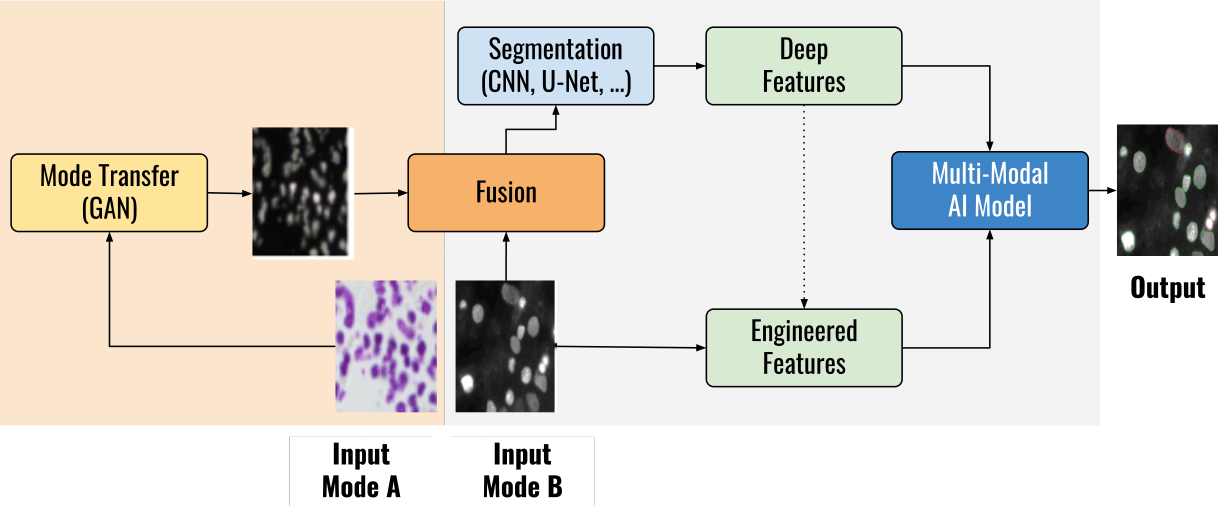
Figure 5. A cell segmentation ensemble approach in combination with Generative Adversarial Network approach (GANs) for multimodal data